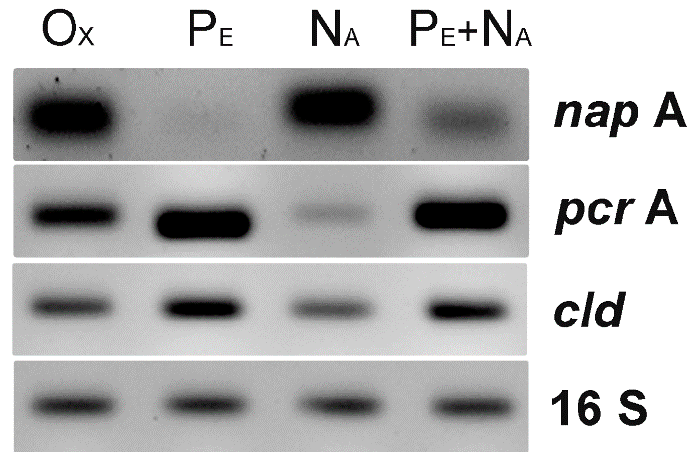
Figure 3. Expression analysis by RT-PCR. mRNAs expression was evaluated in VG medium containing 10 mM sodium acetate as carbon source. At exponential phase cells grown in aerobiosis (Ox) with oxygen as only electron acceptor were inoculated in anaerobic conditions at the presence of perchlorate (PE), nitrate (NA), and both perchlorate and nitrate (PE + NA) as electron acceptors. 16S rRNA expression was used as control for loading. The analysis was performed in triplicate with similar results. A typical experiment is shown.